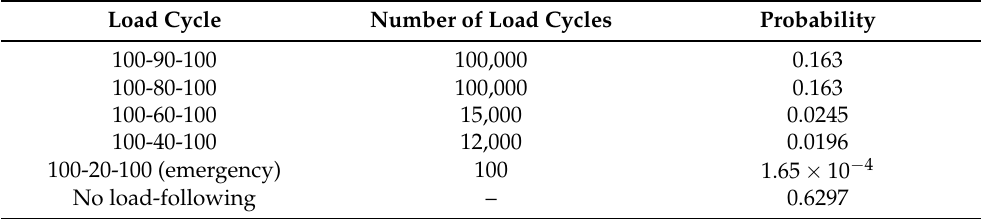
Table 1. PWR reactor load-following capability